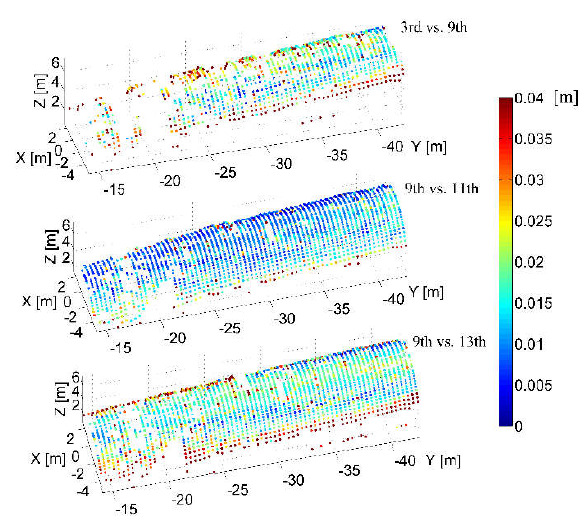
Figure 5. Graphical display of distances between representative points in corresponding blocks with the colour pattern representing the standard deviations.